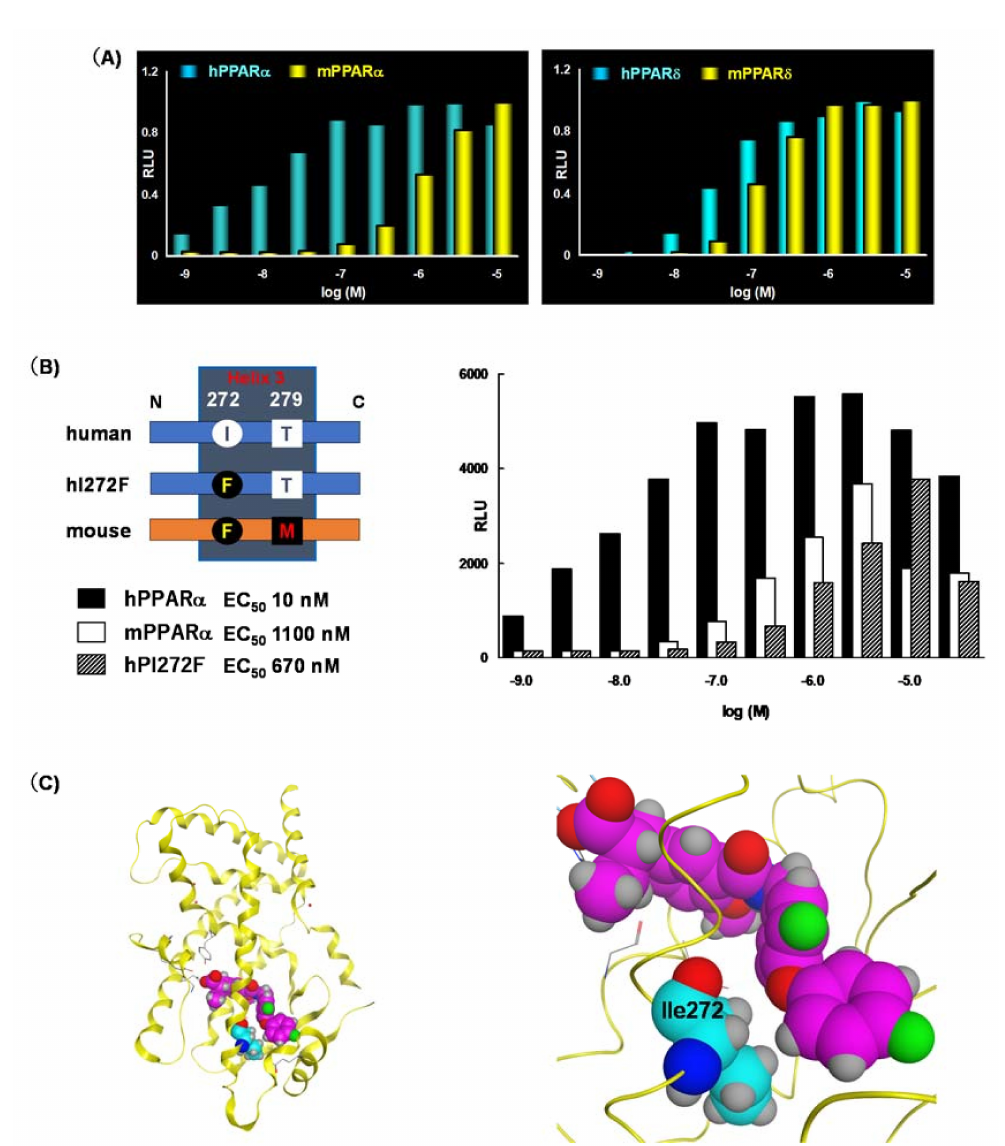
Figure 7. ( A ) Dose response activation of human and mouse PPAR α and PPAR δ by TIPP-401. ( B ) Transactivation assay using point mutants of the PPAR α LBD. ( C ) (left) Overall crystal structure of APHM-19 complexed with PPAR α LBD. (right) Zoomed view of the Ile272 interaction (hydrophobic tail) with APHM-19.